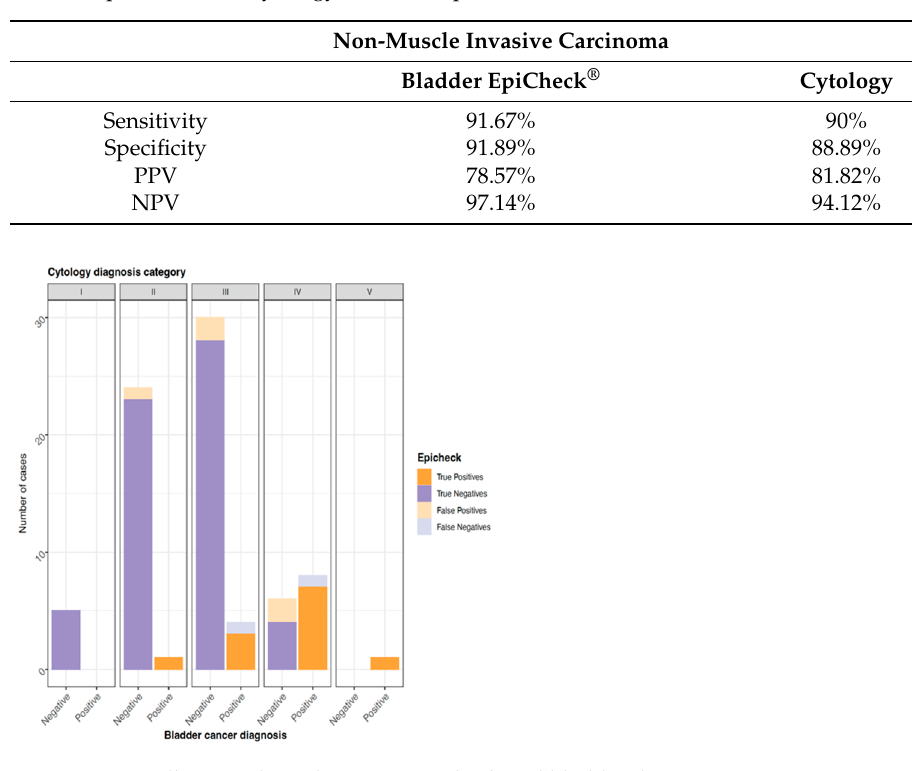
Figure 3. Overall concordance between EpiCheck and bladder diagnosis.